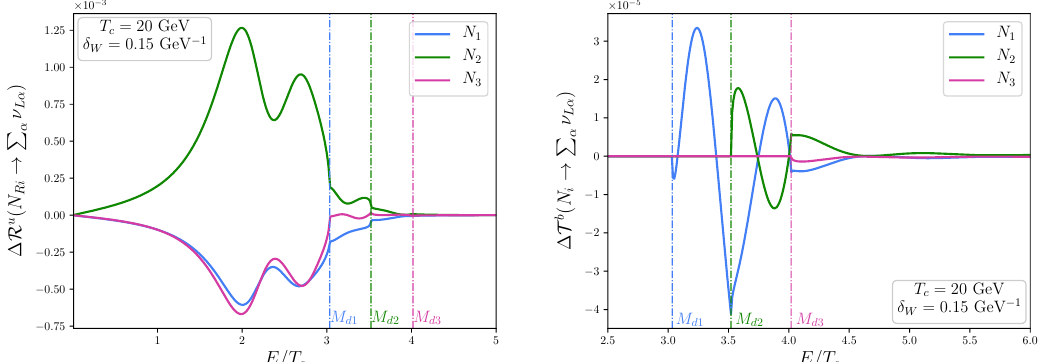
Figure 2 . CP asymmetries from the re(cid:13)ection of states from the unbroken phase o(cid:11) the bubble wall (left panel) and transmission of states from the broken to the symmetric phase (right panel). Here we have used the FLOR pro(cid:12)le de(cid:12)ned in eq. (3.12). M 1 , M 2 and M 3 are set to 60, 70 and 80 GeV respectively while m D has been (cid:12)xed as discussed at the end of section 2. The energy dependence has been normalized to T c , here chosen to be 20 GeV, but it has no actual impact